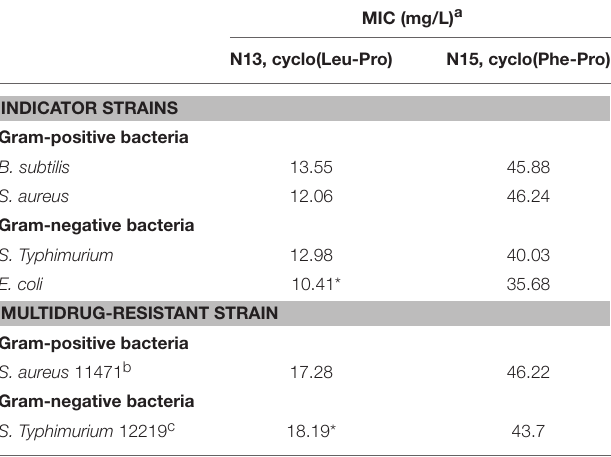
TABLE 4 | Antibacterial activity of N13 and N15 isolated from Ln. mesenteroides LBP-K06